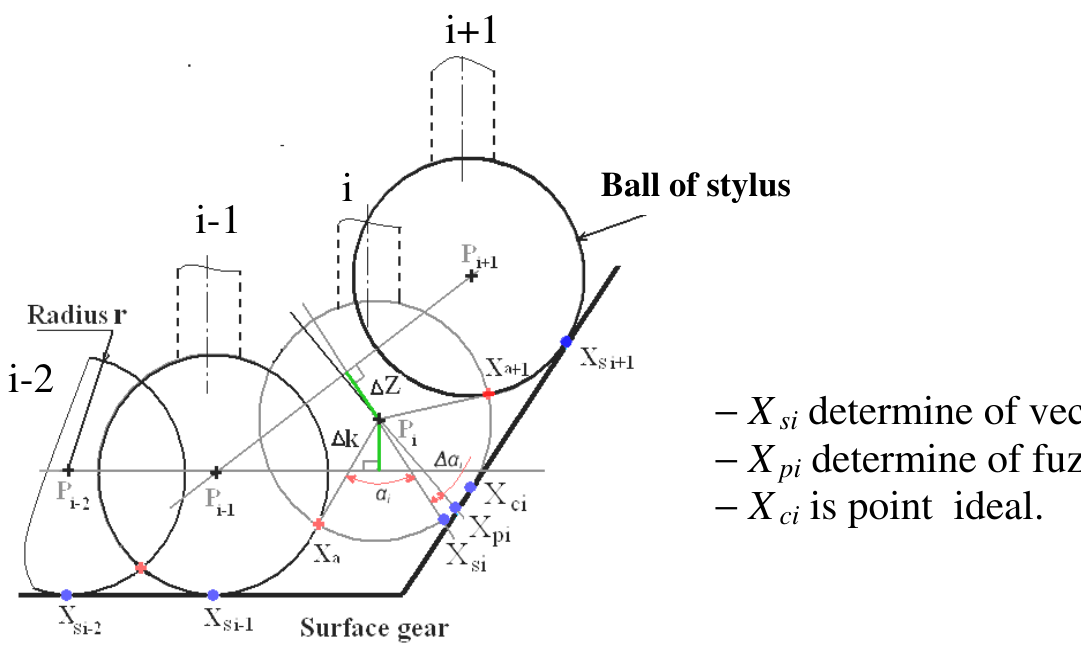
Fig. 4. (Color online) Principle termination Δk, Δα, Δz (view B-B) [1].